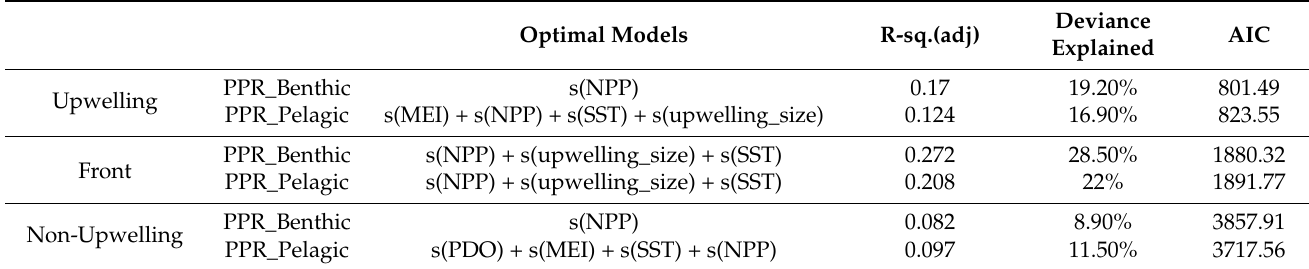
Table 2. Optimal models in each habitat by GAM analysis.